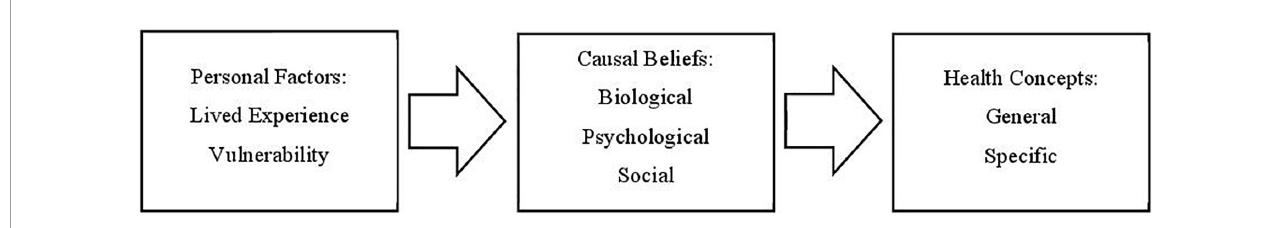
FIGURE1 Theoretical model. Theorized relationships between study variables.